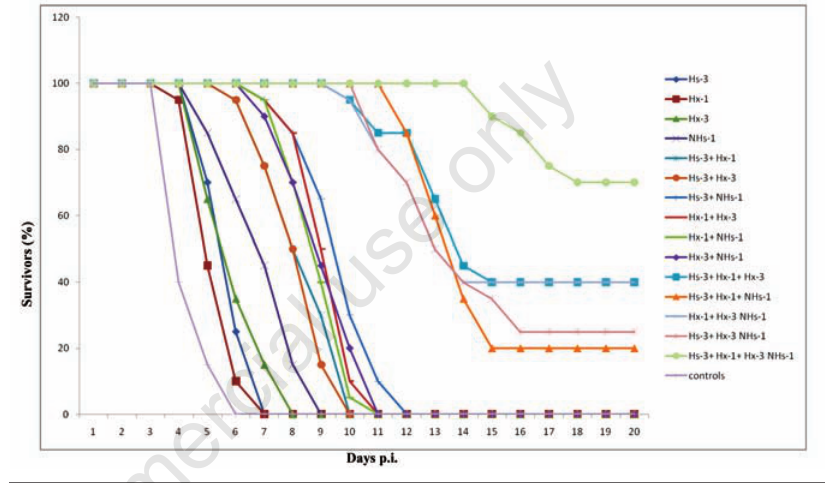
Figure 1. Protective effect of various combinations of monoclonal antibodies to Japanese encephalitis virus glycoprotein E on Japanese encephalitis virus (strain 641686) infected mice. Control mice were given normal immunoglobulin G or normal mouse serum.